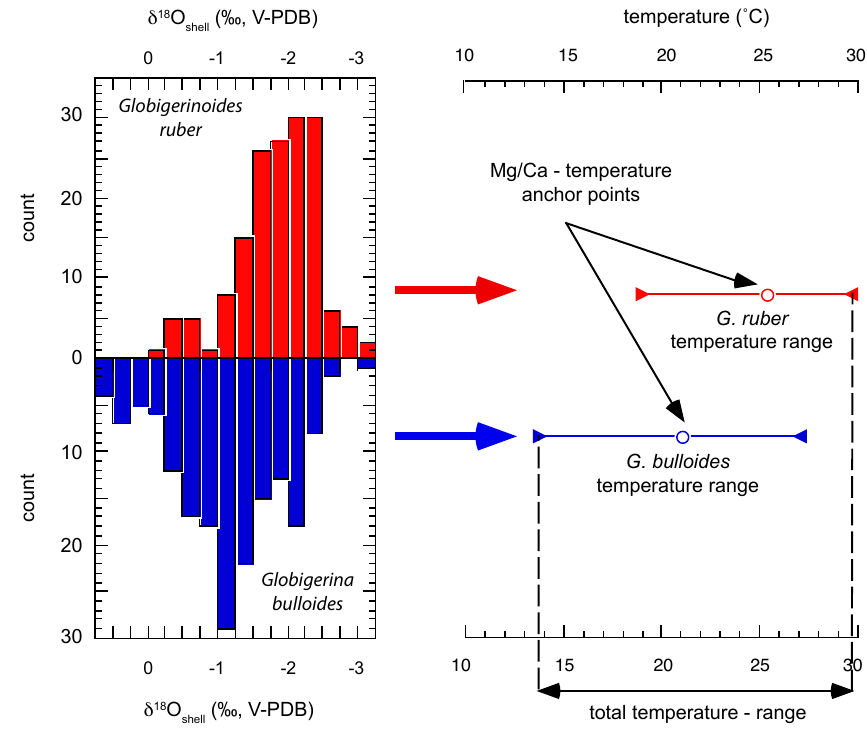
Fig. 2. Oxygen isotope data from all boxcores (902–906) for G. ruber ( n =160) and G. bulloides ( n =177) plotted in 0.25‰ wide bins (left panel) and inferred calcification temperature ranges for both species (right panel). Open dots are the mean temperatures derived from the Mg/Ca analysis of surface sediments from the same cores; the lines indicate the total range of calcification temperatures obtained for each species with the most extreme values indicated by